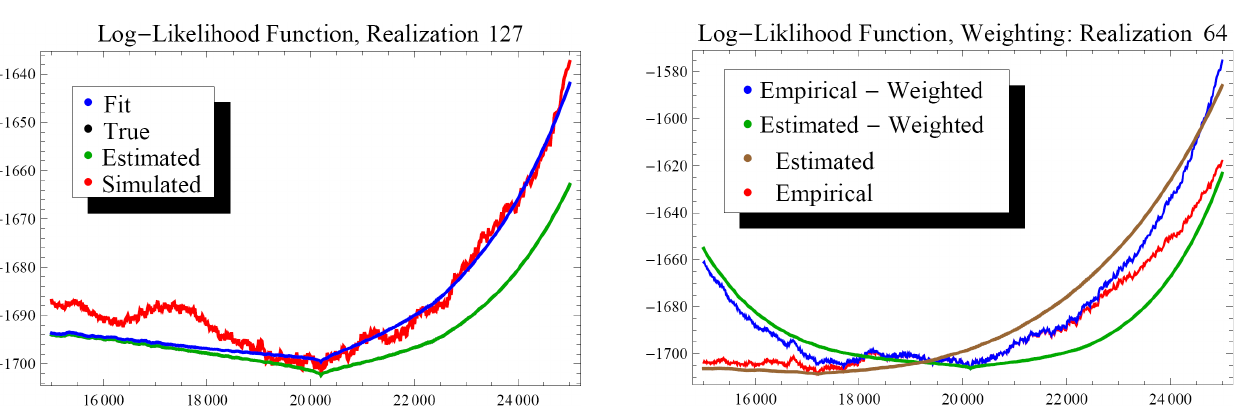
Fig. 18. Log-likelihood functions (as a function of η 1 in km) – empirical and estimated – for the basic and weighted parameter es- timation methods. The data are from realization